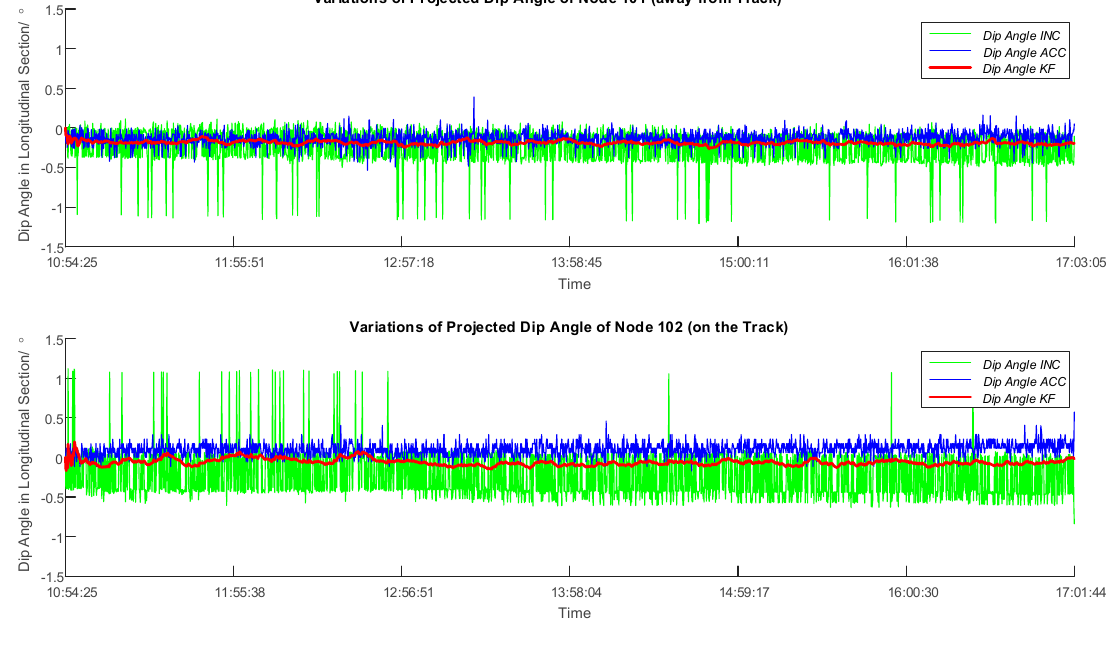
Figure 10. Plots of Dip Angle Variations of Sensor Node 101 (away from Track) and Node 102 (on the